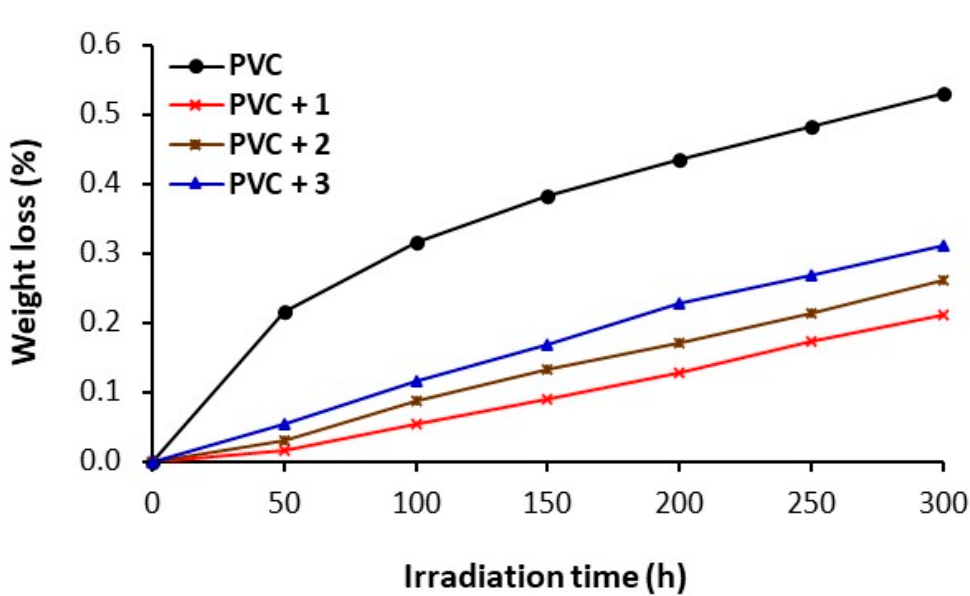
Figure 4. Effect of the time of irradiation on the weight of PVC films.